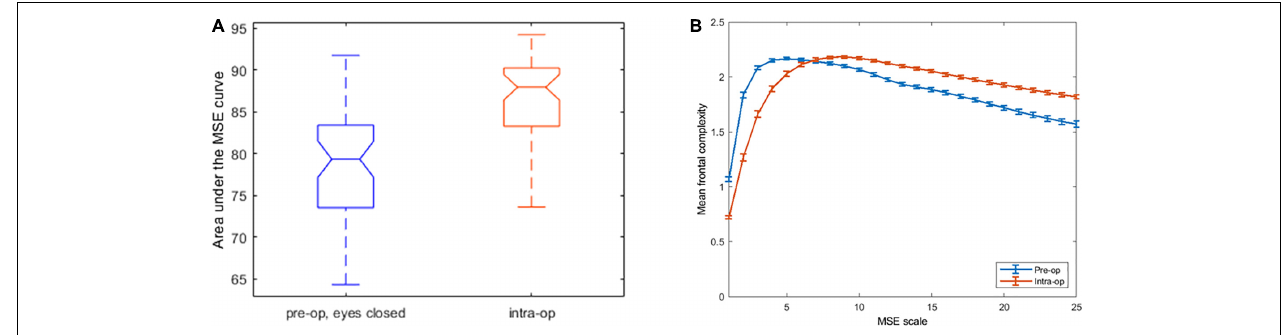
FIGURE 2 | AUC whisker plots (A) and entropy-by-scale curves (B) , averaged across 50 participants. (A) Area under the curve (AUC) for the frontal entropy-by-scale curves for the pre-op eyes-closed awake condition and the surgical/anesthetized condition. AUC complexity values integrated across all 25 scales are higher during anesthesia/surgery relative to the conscious awake condition. (B) Frontal complexity (entropy) values ( Y axis), by time scale ( X axis), averaged across all participants with standard error bars shown. The blue line represents the preoperative awake/eyes closed EEG recording. The red line represents intraoperative/anesthetized EEG recording. Note the clear crossover point between scales 7 and 8, where the pre-operative complexity values are higher (compared to intra-operative complexity values) to the left of this point but are lower to the right of this point.